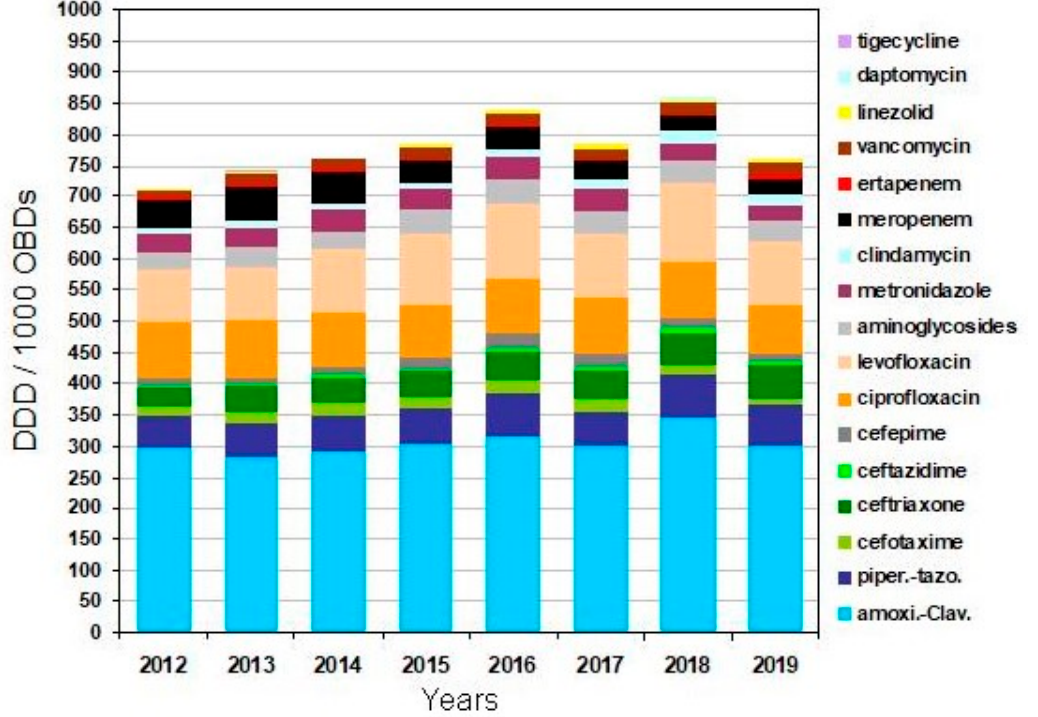
Figure 2. Evolution of antibiotic consumption between the years 2012 to 2019.